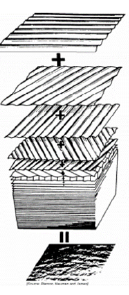
Figure 6. Regular waves superposition, adapted from